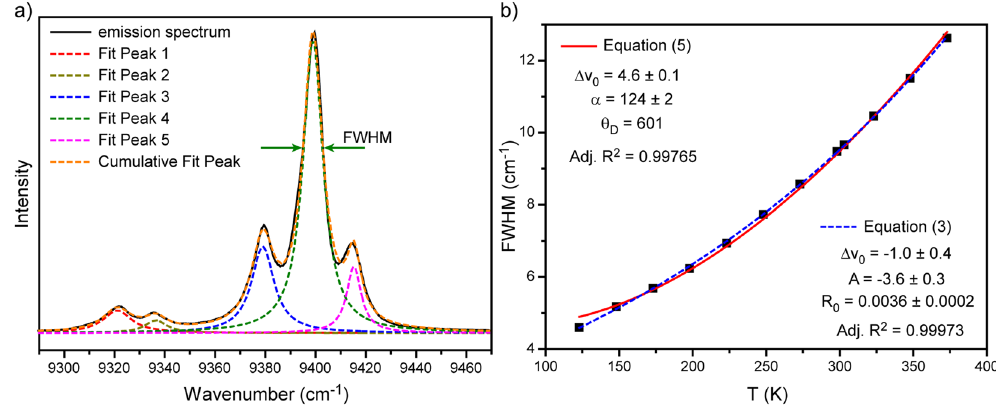
Figure 3. ( a ) Deconvolution of 4 F 3/2 (R i ) − 4 I 11/2 (Y j ) transition; ( b ) FWHM of 4 F 3/2 (R 1 ) − 4 I 11/2 (Y 1 ) transition as a function of temperature with fits to equations (5) and